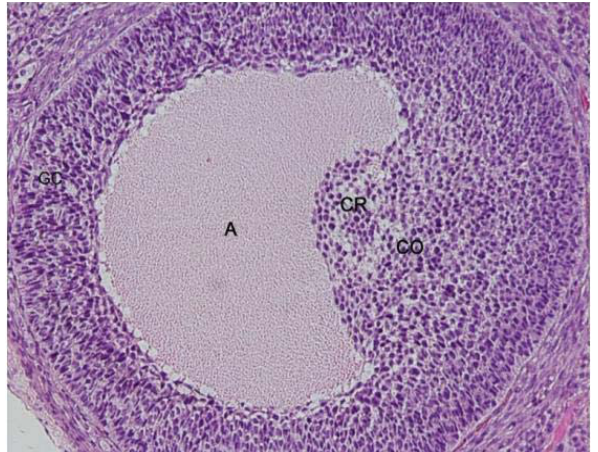
Fig-2: Photomicrograph Graafian follicle of control group showing well arranged granulosa cells (GC), follicular antrum (A), cumulous oophorus (CO) and corona radiate (CR), (H & E, 20x).